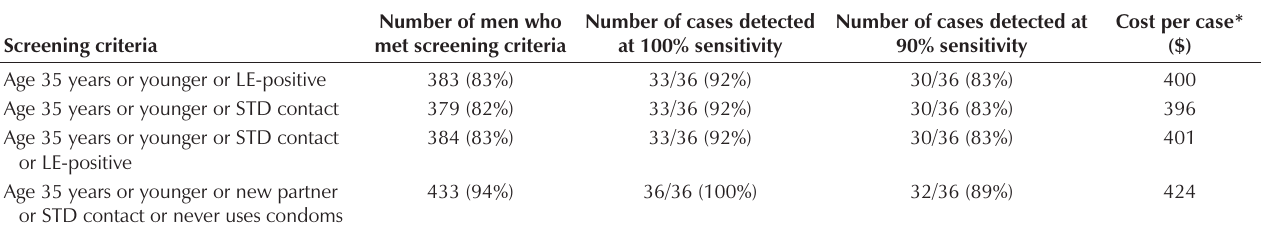
TABLE 5 Cost of different screening strategies for men younger than age 35 years attending a sexually transmitted disease (STD) clinic Screening criteria